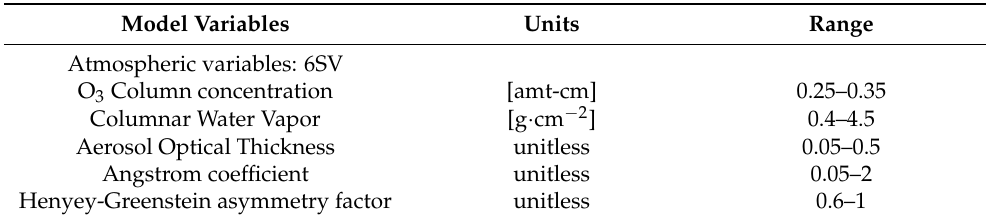
Table 2. Range of 6SV input variables used for the simulations of the atmospheric transfer